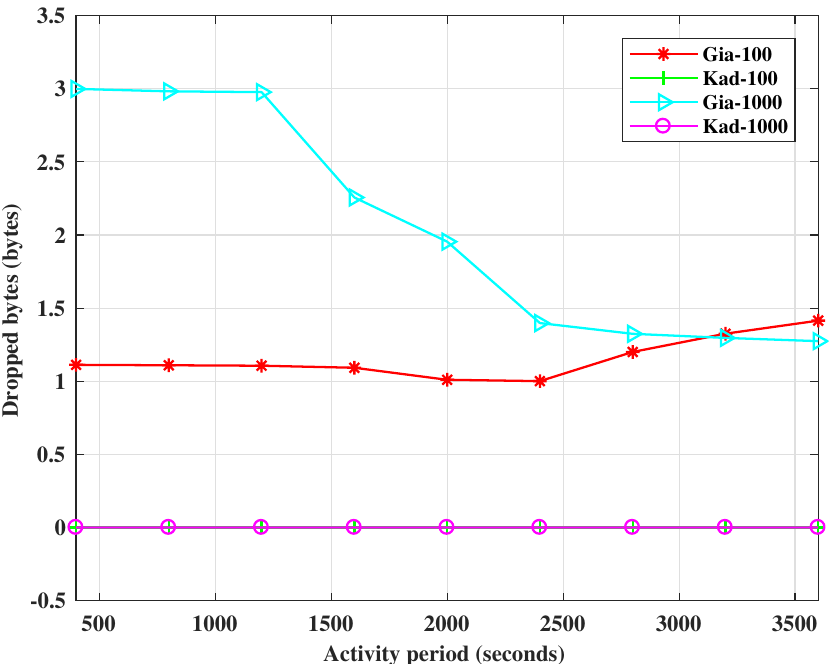
Figure 8. Comparison of the number of dropped messages by each protocol during peer